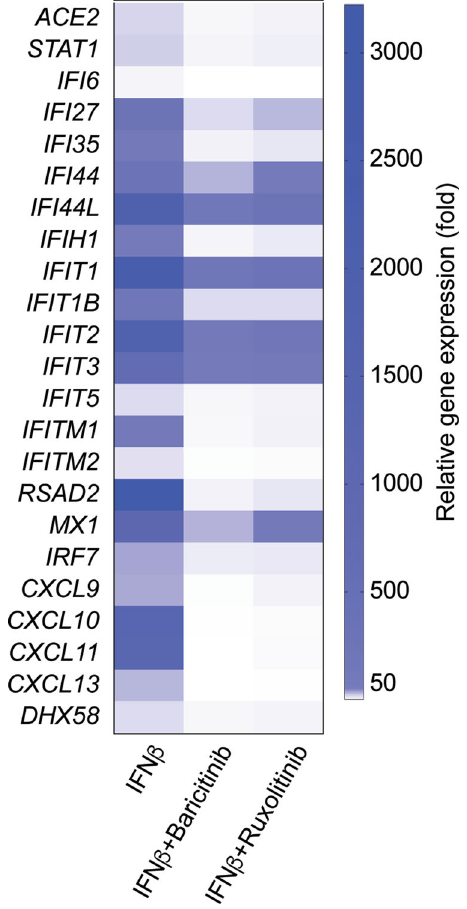
Fig. 5 JAK inhibitors suppress distinct interferon-regulated immune pathways. Heat map comparison of relative expression levels of representative interferon-responsive genes in SAECs stimulated with IFN β ( n = 3) alone or with IFN β and JAK inhibitors ( n =